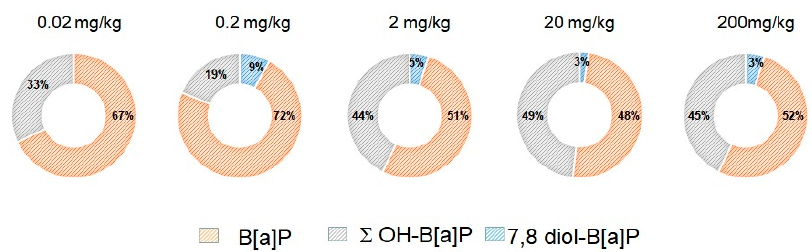
Figure 2. Molar percentage of B[a]P, sum of OH-B[a]P and 7,8-diol-B[a]P recovered in ( A ) serum and ( B ) cerebral cortex of mice exposed via oral administration using doses up to 200 mg/kg for 11 consecutive days. Data are mean +/ − SEM ( n = 10 per group). In the cortex, a different metabolite pattern was seen (Figure 1B). At 0.02 mg/kg, only B[a]P and 9-OH-B[a]P were detectable while all analytes except 1-OH-B[a]P were above the limit of quantification in mice exposed to doses of 0.2 mg/kg or higher. B[a]P was the most abundant in this matrix, followed by its 3-OH-B[a]P, 1-OH-B[a]P, 9-OH-B[a]P and 7,8-diol-B[a]P metabolites irrespective of the dose administered (Figure 2B). The relative percentage of B[a]P in cerebral cortex decreased from 100% in control group to 52% at 2 mg/kg. From the later dose to 200 mg/kg, equivalent proportions between B[a]P and me- tabolites were shown (Figure 2B). A repartition of 48%:52% was therefore observed at the highest dose (200 mg/kg) corresponding to the sum of mono- and dihydroxylated-B[a]P and B[a]P, respectively (Figure 2B). The 7,8-diol-B[a]P metabolite was measured in brain from 0.2 mg/kg upward and the relative level in the cerebral cortex decreased from 9% at 0.2 mg/kg to 3% at the two highest doses (2–200 mg/kg of B[a]P). There were strong linear relationships (R 2 value comprised between 0.833 and 0.923 Spearman analysis, n = 28, p < 0.001) between the concentrations of B[a]P or OH-B[a]Ps in serum and their corresponding concentrations in the brain collected from exposed rats, as shown in Figure 3. The relationship between 9-OH-B[a]P in serum and brain was stronger (Figure 3, R 2 = 0.923, n = 28, p < 0.001, Spearman analysis) followed by 7,8-diOH-B[a]P for which a R 2 value of 0.894 was determined ( n = 28, p < 0.001, Spearman analysis).